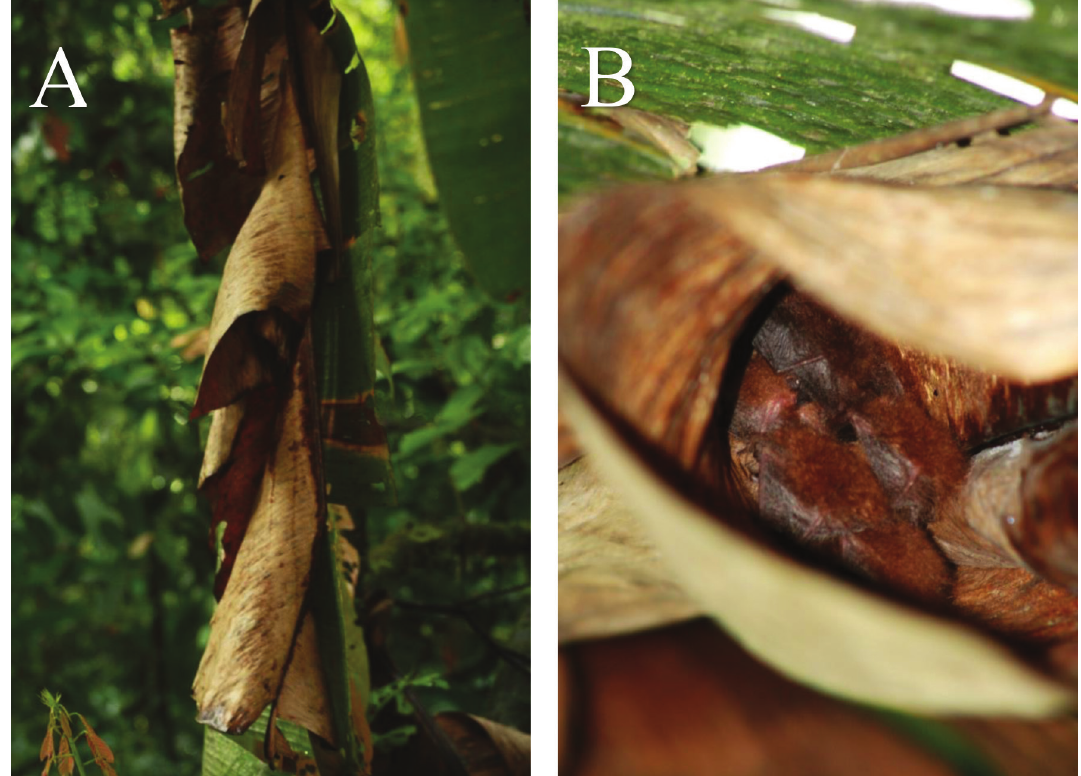
Figure 6. A – Roost of Thyroptera discifera in a (Musaceae) from the Caribbean lowlands of Costa Rica. B – View of the colony T. discifera inside the leaves of Musa × acuminata . Photos by Bernal